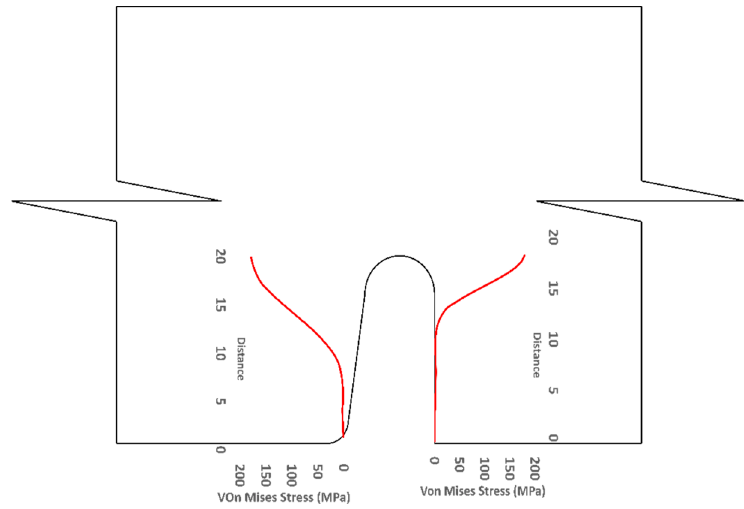
Figure 28. Von Mises Stress (MPa) of primary folding link bars (factored gravity load of 4 kPa).